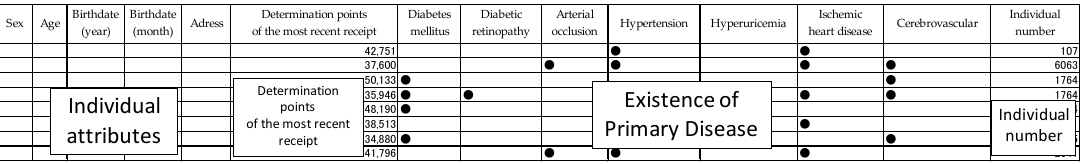
Figure 3. Example of MHLW form (Form 2-2) (source: created from the KDB data of Hakui City).